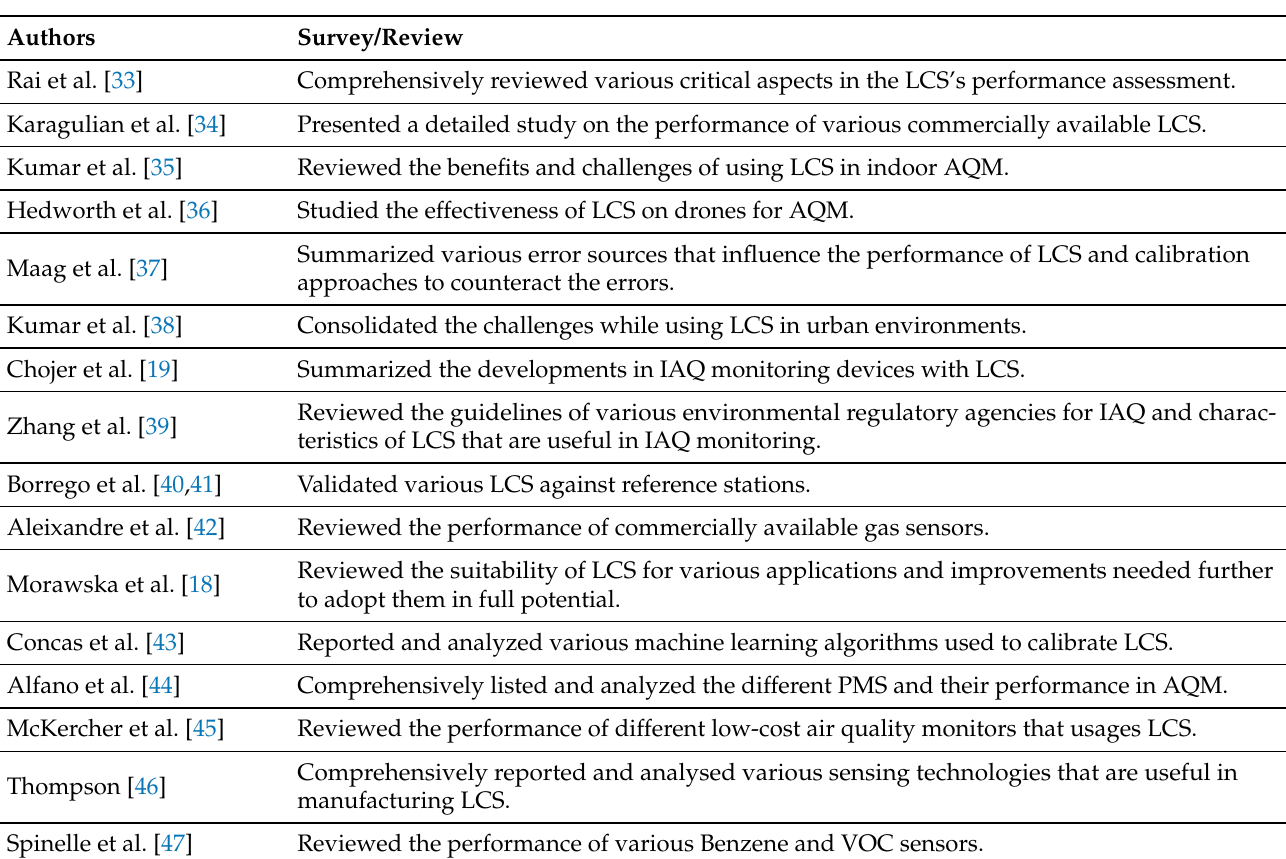
Table 1. Various surveys/reviews on LCS for AQM. Here, LCS: low-cost sensors, AQM: air quality monitoring, IAQ: indoor air quality, VOC: volatile organic